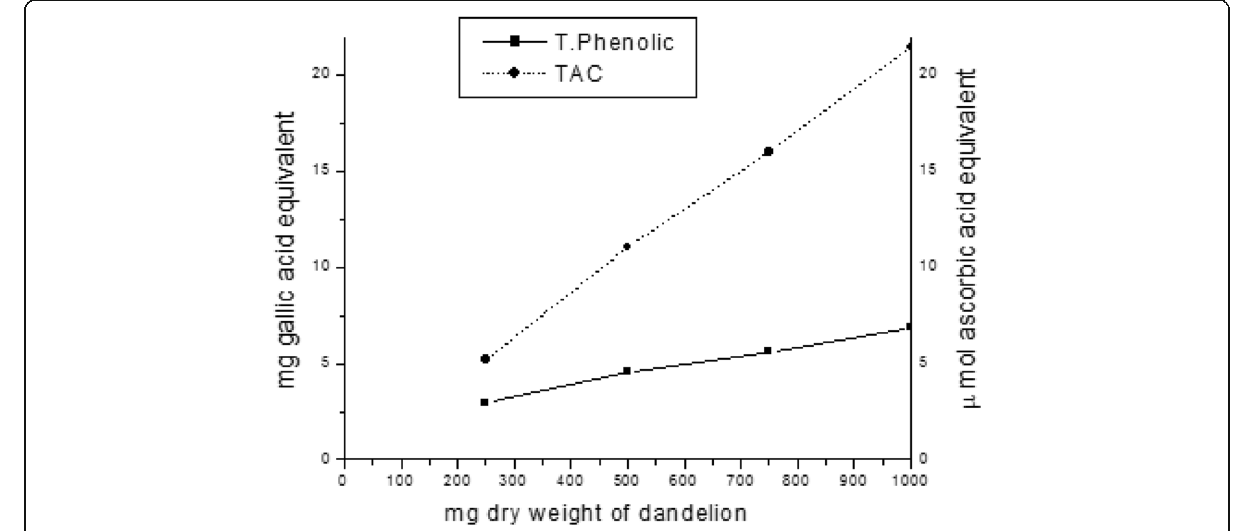
Fig. 1 Total phenolic and total antioxidant contents of